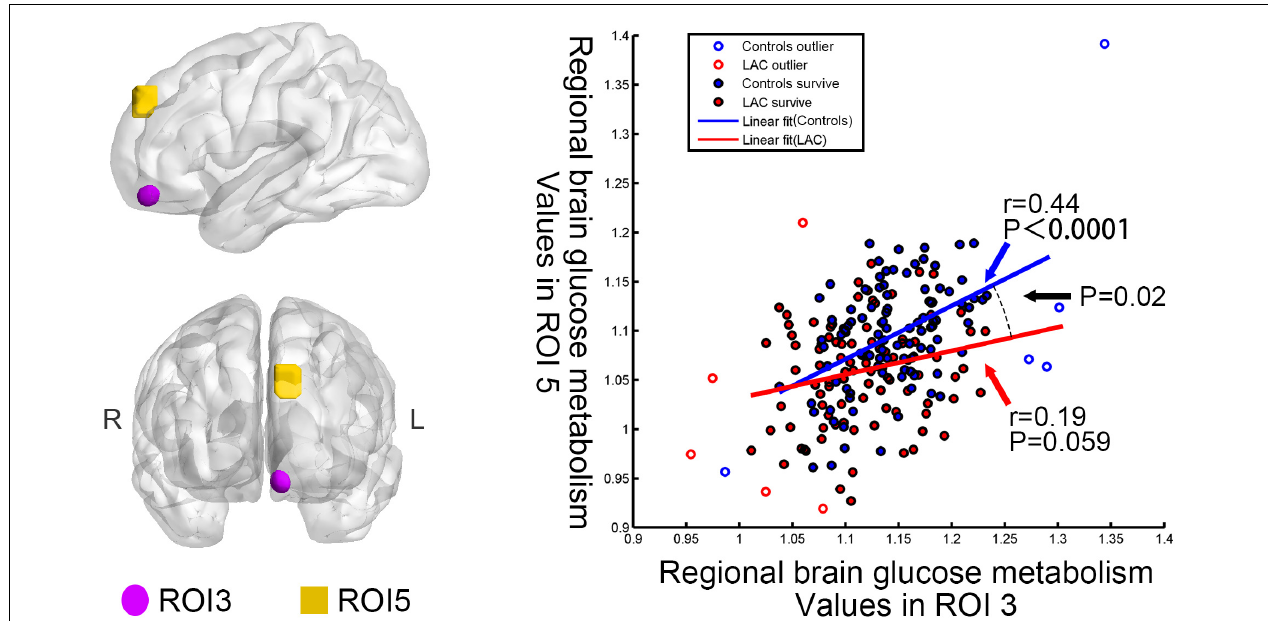
FIGURE 2 | Differences in interregional correction between the post-chemotherapy group and the control group. Regional brain glucose metabolism values in the ROI 3 correlated with those in the ROI 5 for the control group ( r = 0.44, p < 0.0001). No significant correlation emerged in the post-chemotherapy group ( r = 0.19, p = 0.059). The interaction linear-model analysis showed that the post-chemotherapy group and the control group had different interregional correlation of regional brain glucose metabolism values (uncorrected p < 0.05). LAC: lymphoma patients after chemotherapy.